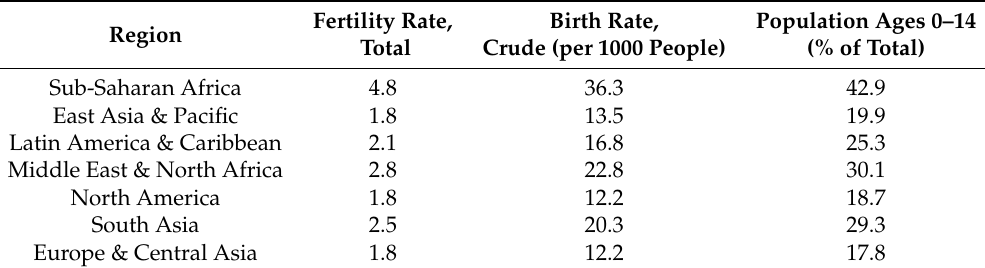
Table 8. Regional breakdown of analyzed data